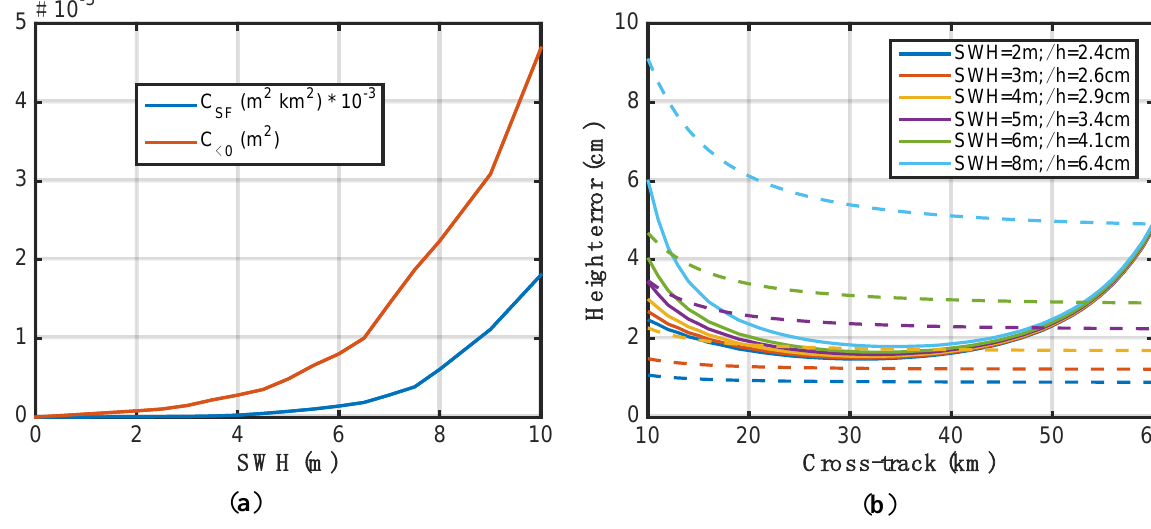
Figure 8. ( a ) Coefficients that best fit the WAVEWATCH-III results for height variance versus cross track distance, according to Equation (10) ( b ) Height error for 1 km × 1 km pixels as a function of cross track due to random noise (solid) and the nonlinear wave energy transfer (dotted) for several SWH. The legend indicates the swath average height error for each SWH.